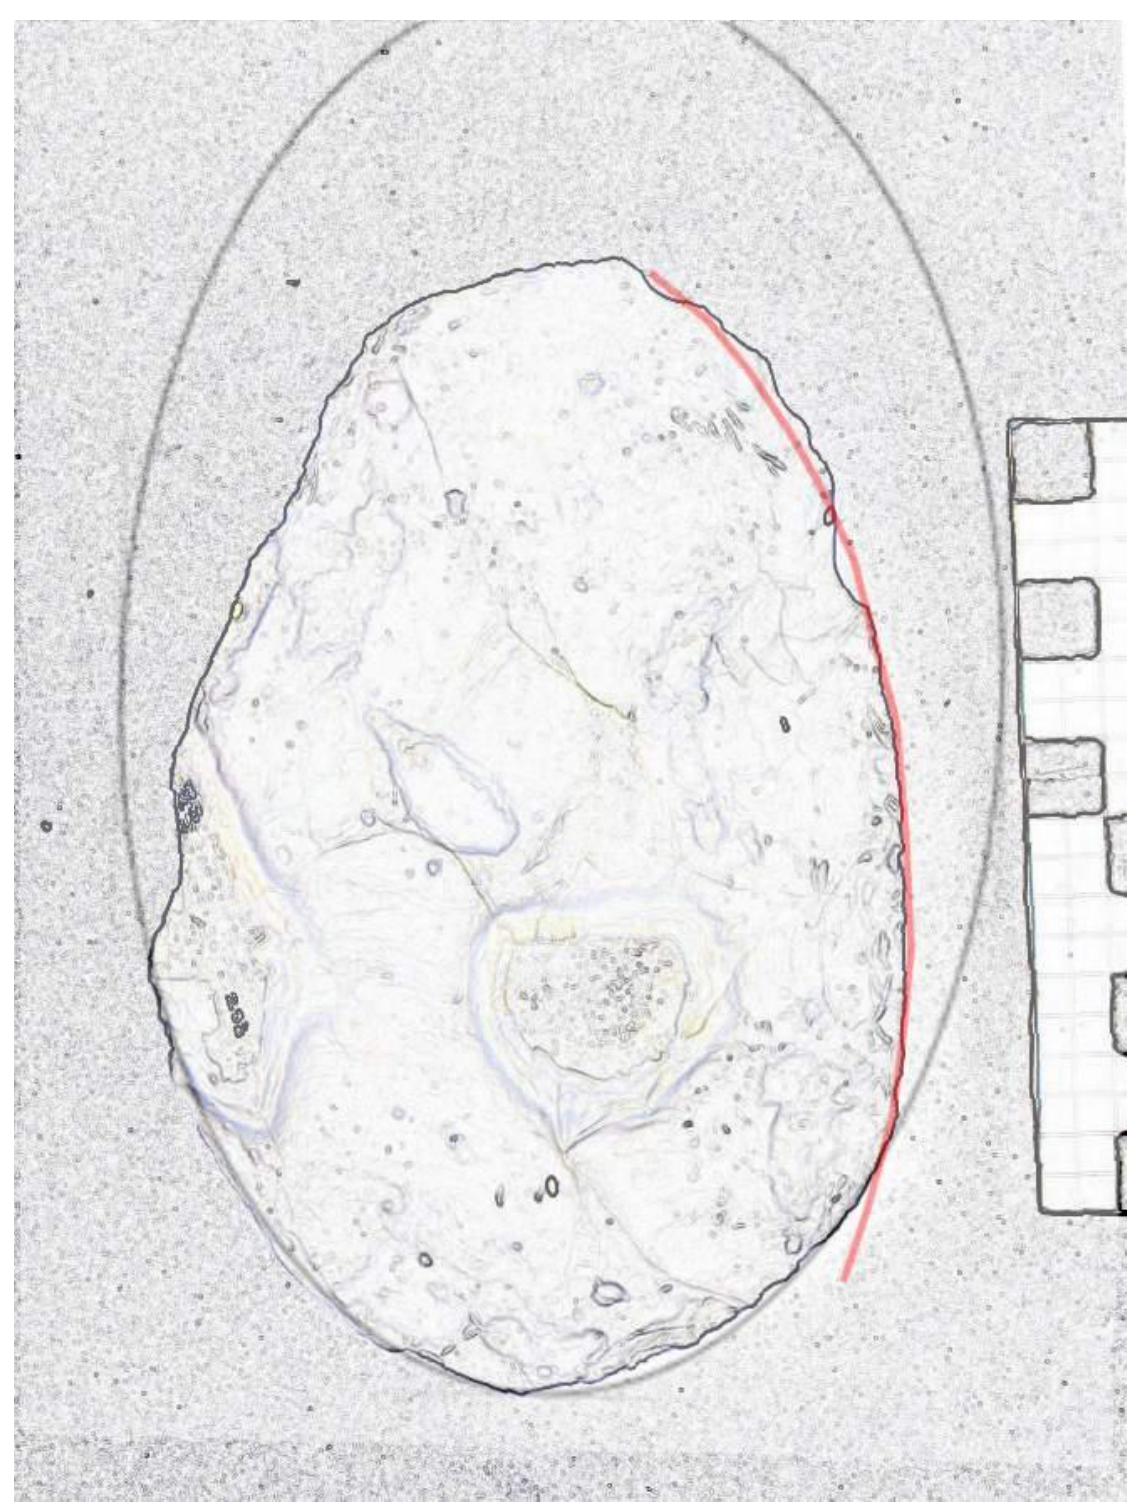
Figure 12. Specimen